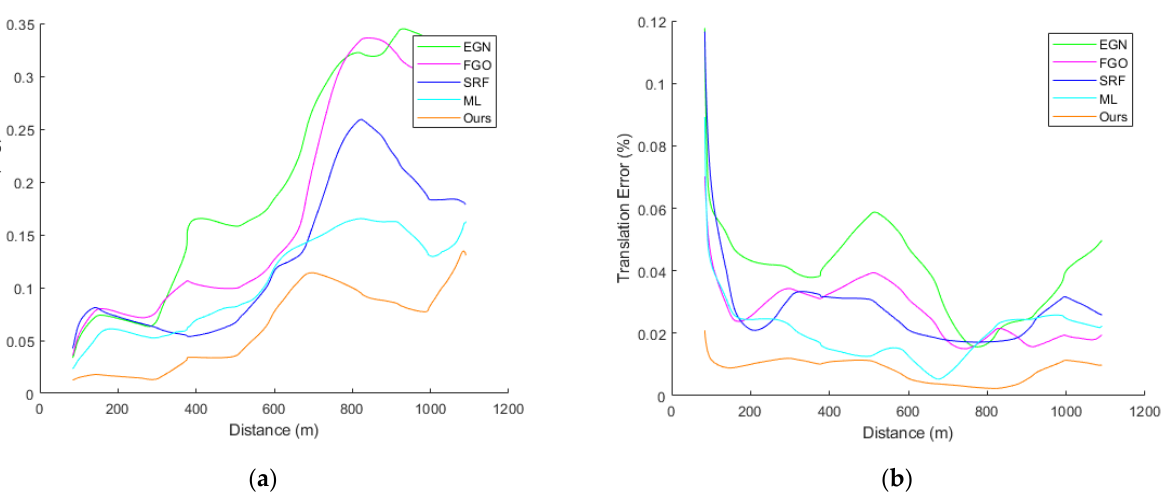
Figure 9. The pose determination errors of the planetary rover with respect to the travel distances, where ( a ) is rotation errors and ( b ) is translation errors.